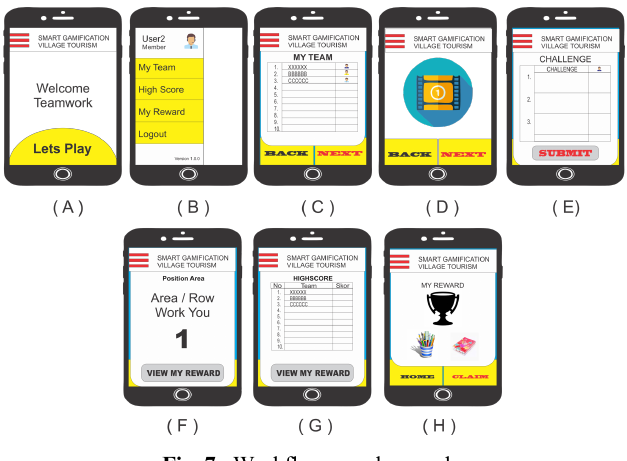
Fig. 7. Workflow member